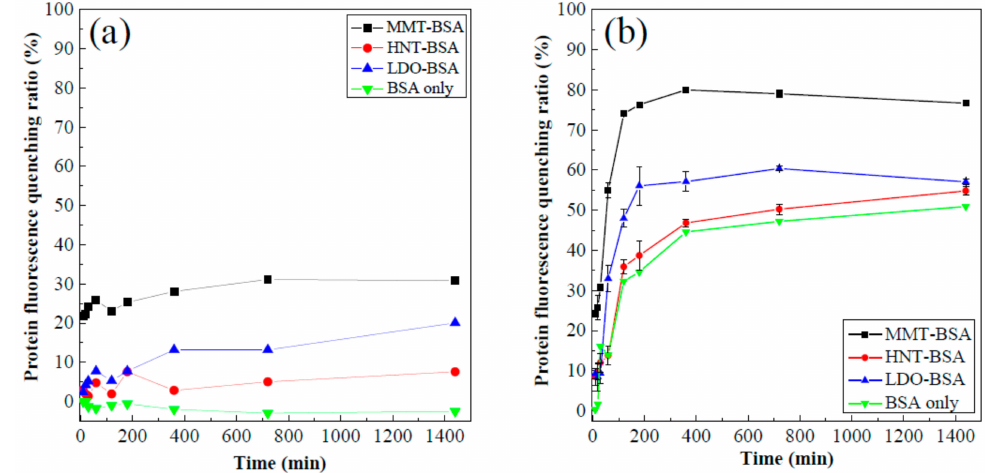
Figure 6. Protein fluorescence quenching ratio depending on time at ( a ) 25 ◦ C and ( b ) 60 ◦